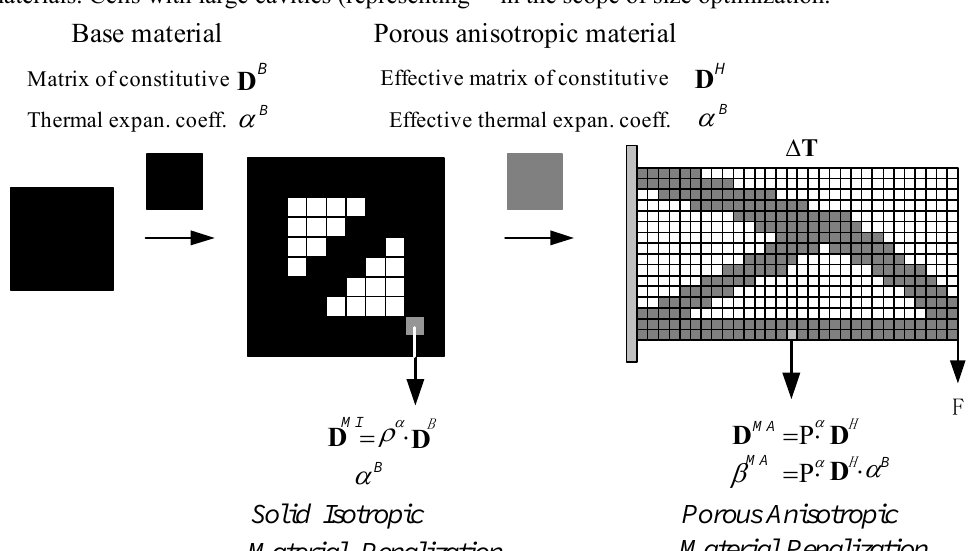
Fig. 1. Penalization-based concurrent optimization with two classes of density as design